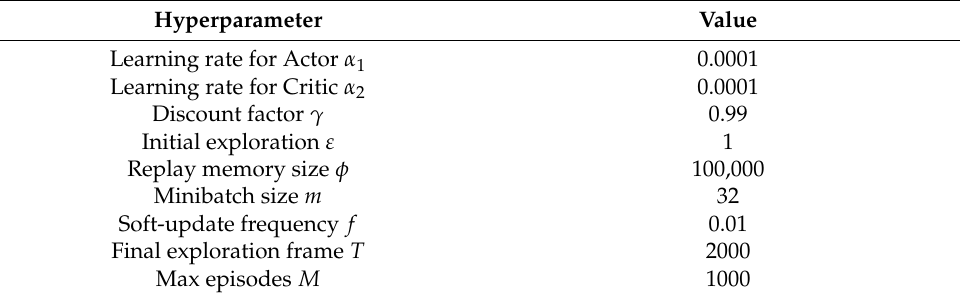
Table 3. DDPG or SumTree ‐ DDPG’s hyperparameter in environment 1.